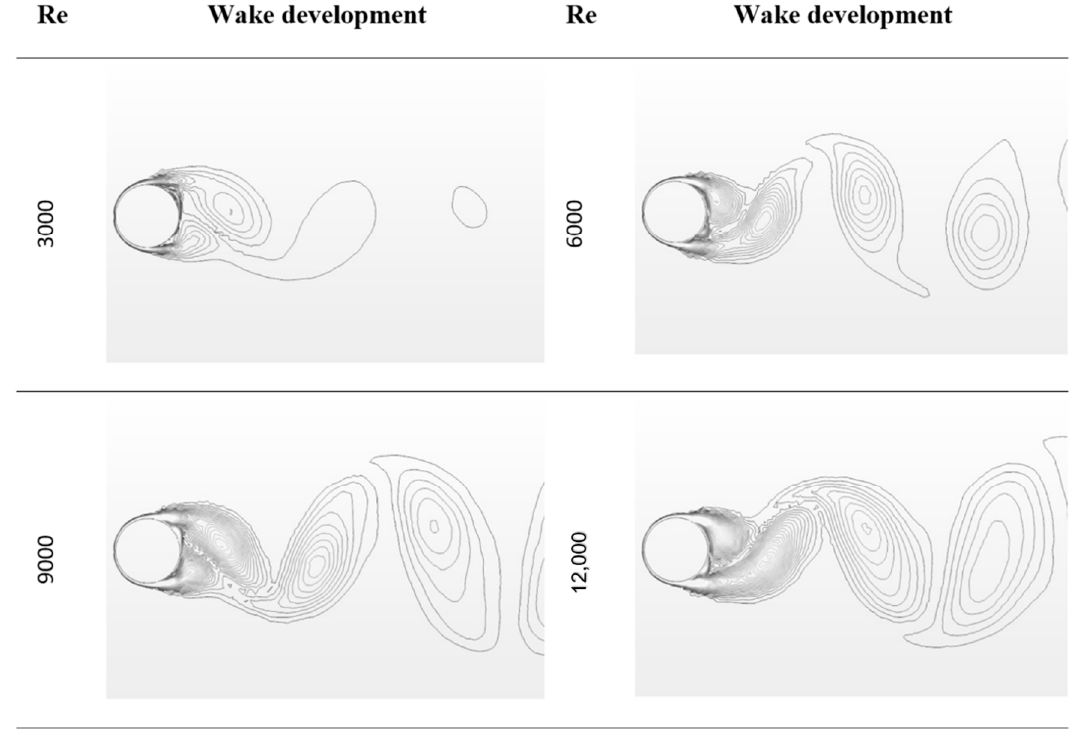
Figure 5. Vortex shedding comparison behind a circular cylinder at different Reynolds numbers.